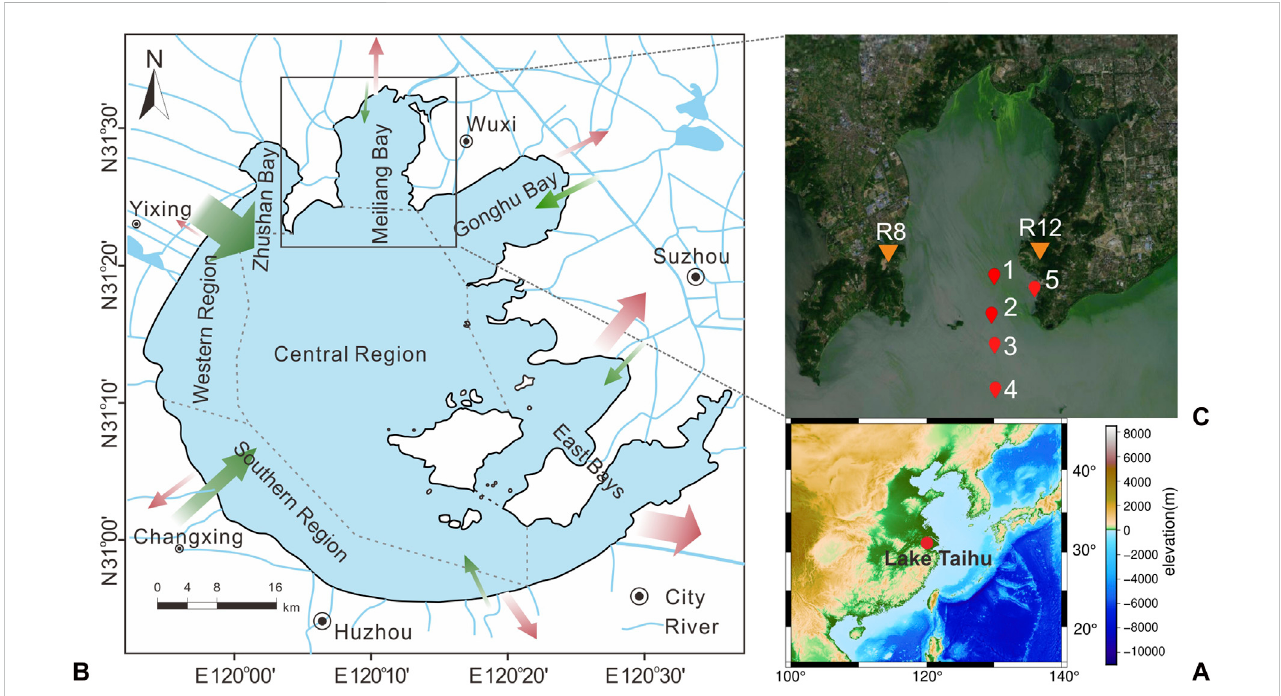
FIGURE 1 Sketch map showing the location of Lake Taihu (A) and sampling Sites 1 – 5 (C) from meiliang bay to the central region (B) . In fl ow and out fl ow of Lake Taihu are indicated as green arrows and red arrows, respectively, with the size of the arrow as a measure of relative runoff (website http://www.tba.gov.cn/).